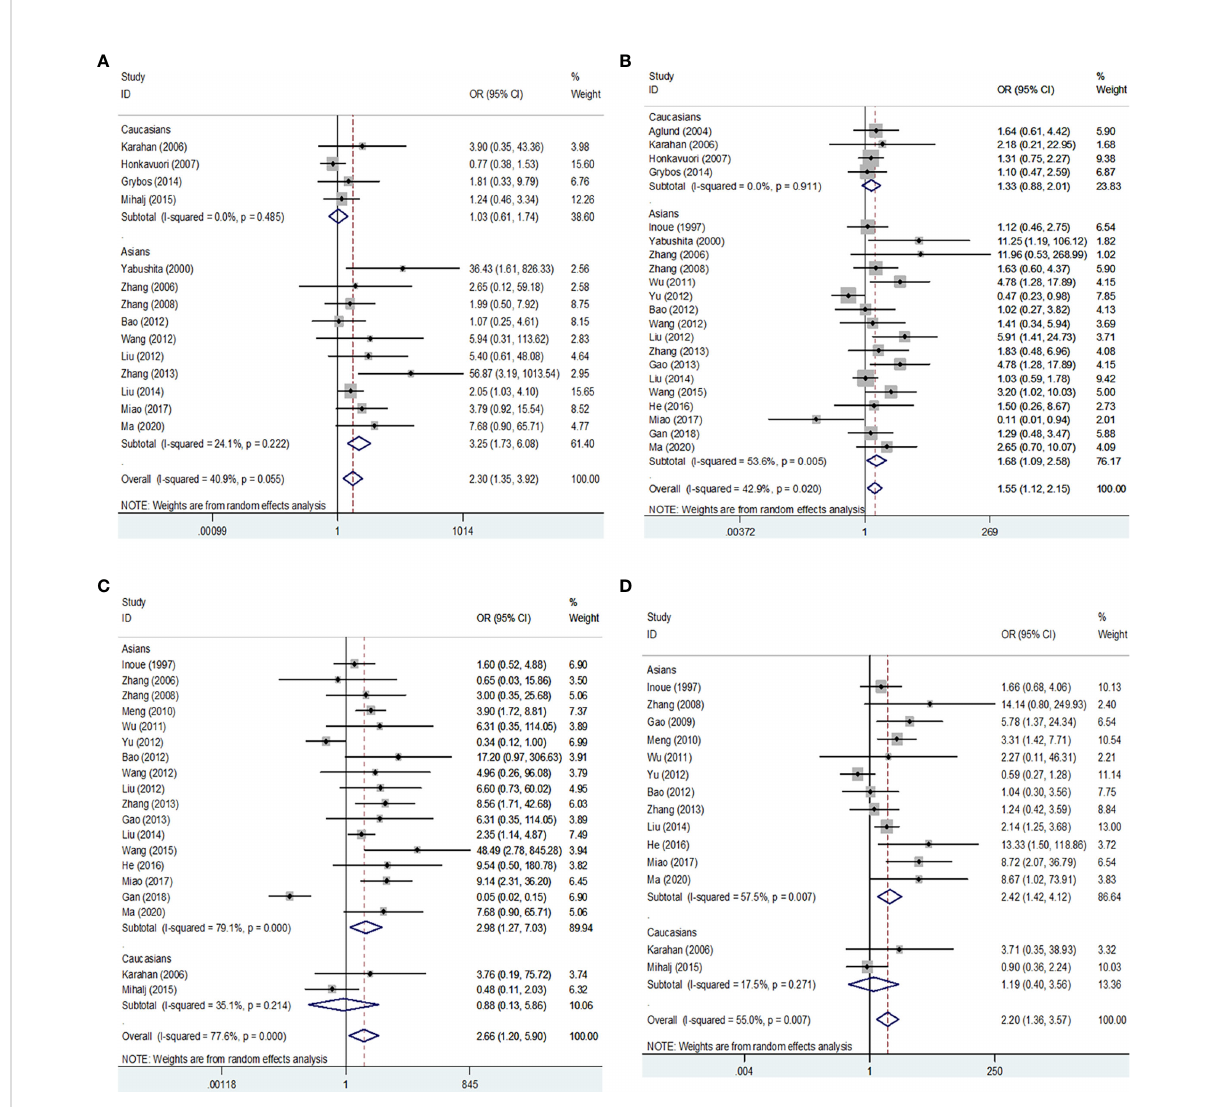
FIGURE 3 Forest plots for the associations of MMP-9 overexpression with clinical features of EC in Asians and Caucasians. (A) Forest plot for FIGO stage of EC. (B) Forest plot for endometrial tumor grade. (C) Forest plot for lymph node metastasis of EC. (D) Forest plot for myometrial invasion of EC. OR, odds ratio; EC, endometrial